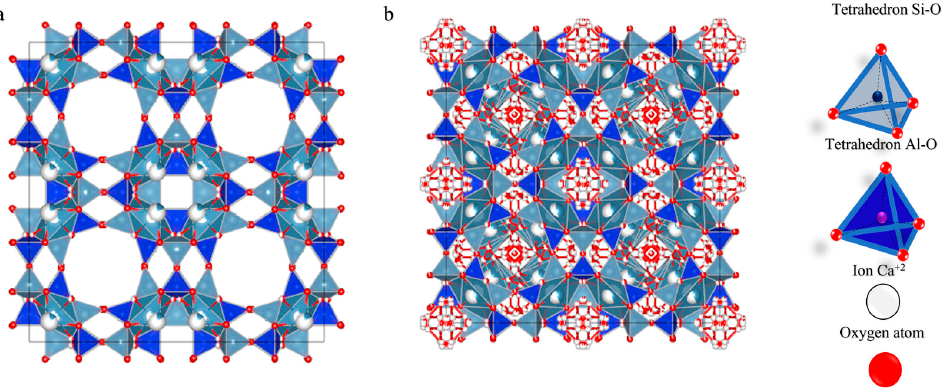
Figure 5. Zeolite 5A structure ( a ) sample before refinement; ( b ) sample refined by the Rietveld method. The images were obtained with VESTA software.